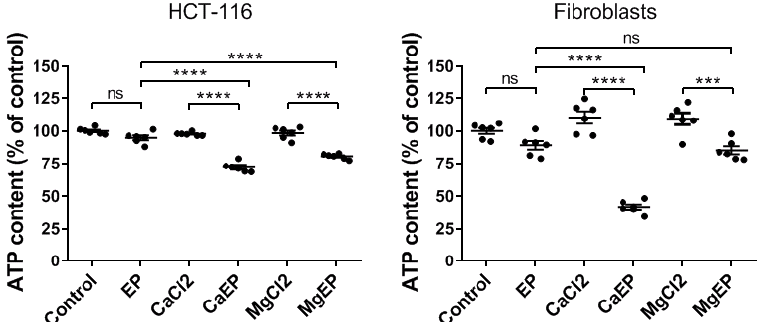
Figure 4. Intracellular ATP depletion within 5 min after electroporation associated with 5 mM calcium. ATP intracellular content was quantified by luminescence assay in HCT-116 cells and dermal fibroblasts. EP: electroporation. Value represents the mean ± SEM ( n = 6). Statistical differences were analyzed by one-way ANOVA followed by Tukey’s post-test. ns: non-significant. *** p ≤ 0.001; **** p ≤ 0.0001.